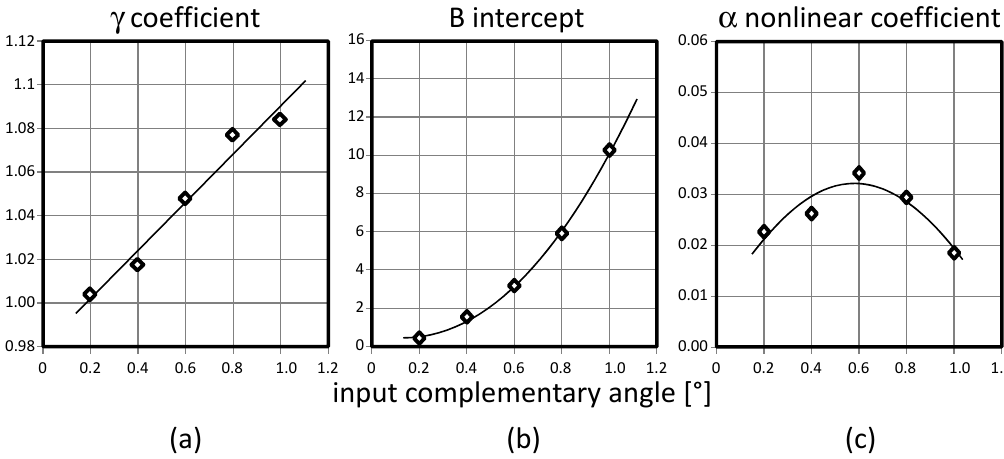
Figure 5. ( a ) From the slopes of the regressions in Figure 4, the γ coefficients of the Generalized Snell Law are calculated. They still follow a linear trend as the function of the input angle. ( b ) The interceptions of the regressions in Figure 4 scale quadratically with the input angle. ( c ) The discrepancy between the trends in Figure 5a,b gives the most efficient EO nonlinearity at a 0.6° input complementary angle.